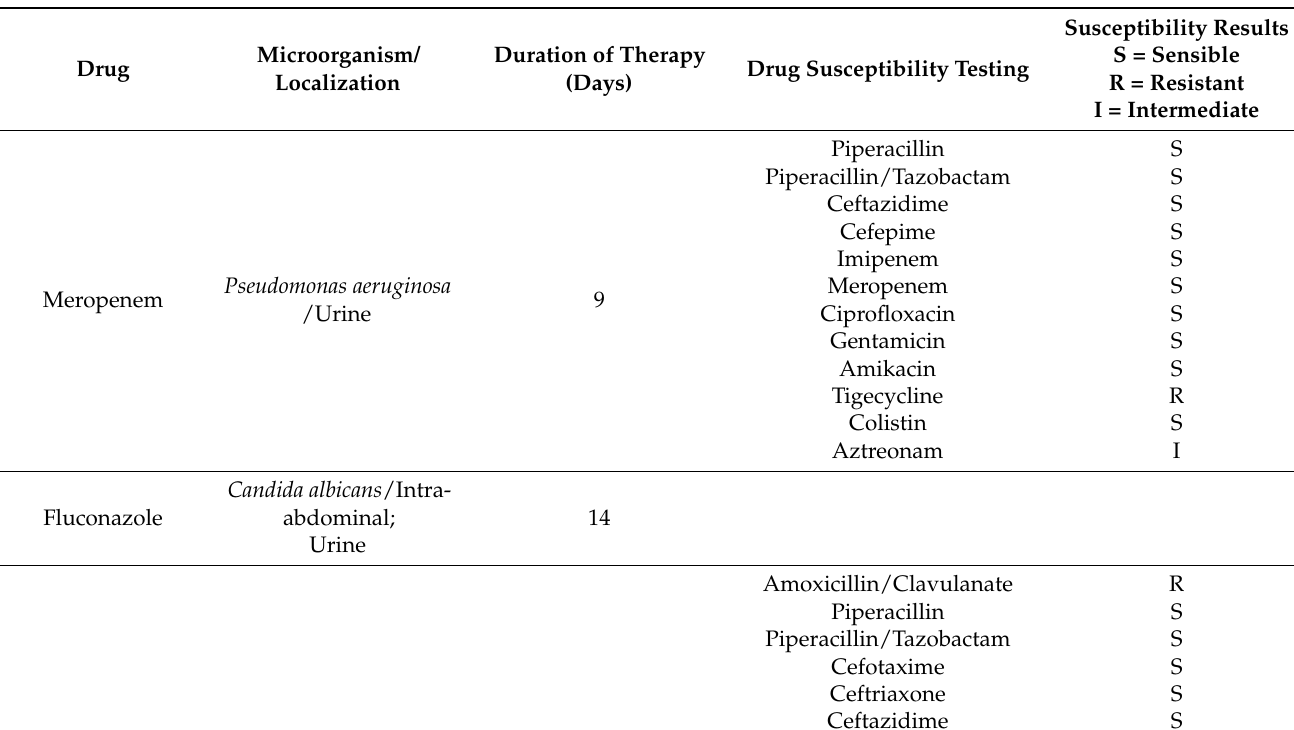
Table 1. Microorganisms found and antibiotic susceptibility testing